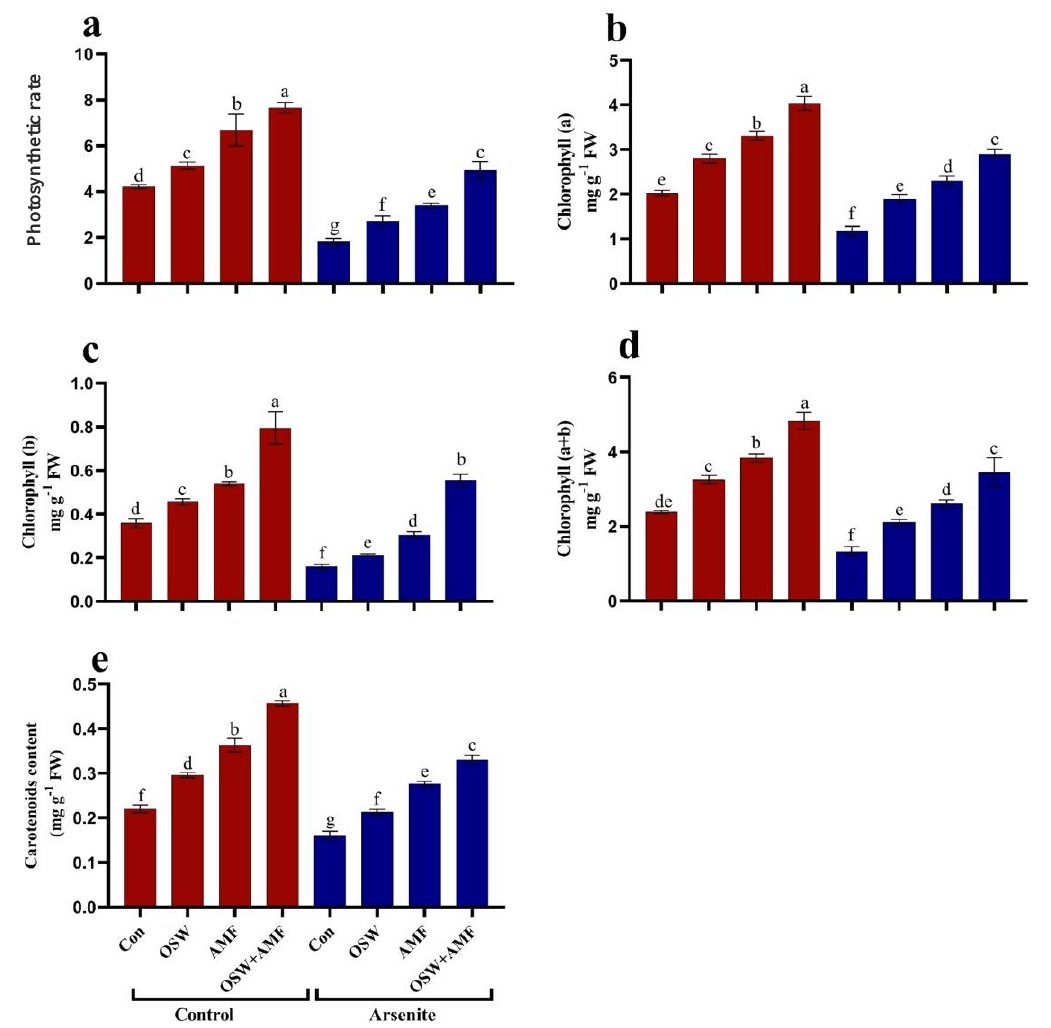
Figure 2. The influence of olive solid waste (OSW) and arbuscular mycorrhizal fungi (AMF), combination (OSW + AMF) on photosynthetic rate ( µ mol CO 2 m − 2 s − 1 ) and photosynthetic pigments (mg/gFW) in wheat plants growing under As III stress. Photosynthesis rate ( a ) Chlorophylla, ( b ) Chlorophyll b ( c ), Chlorophyll a+b ( d ), carotenoids ( e ). Fishers test at p < 0.05 reveals significant variations in means (± standard deviation), which are different letters on the same bars.